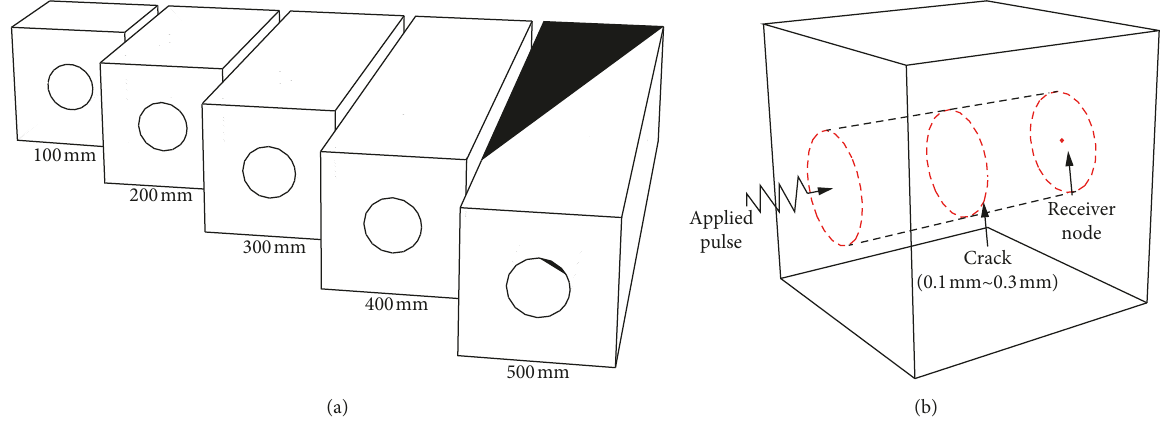
Figure 14: Simulation test blocks: (a) with different measuring distances; (b) with different crack